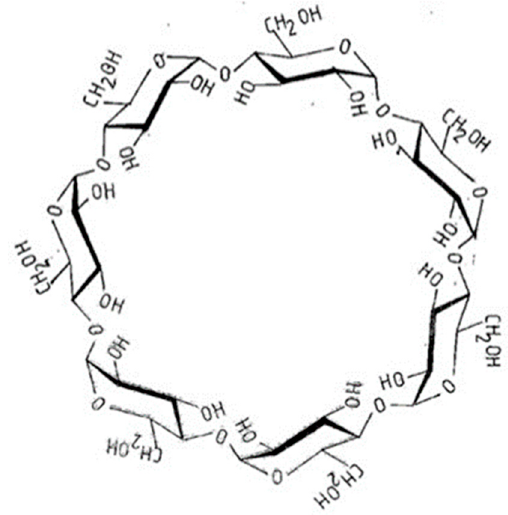
Figure 2. The structure of the β -cyclodextrin. The central cavity of the molecule can include guest molecules [28].